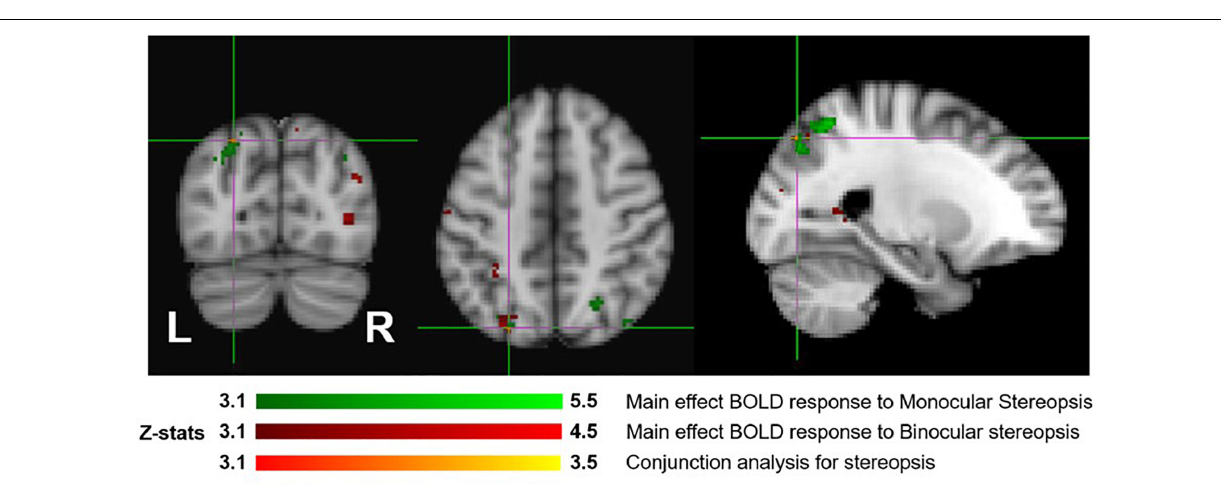
stereopsis contrast and not in the binocular stereopsis contrast. Specifically, in the monocular stereopsis contrast two clusters in the left parietal cortex [MNI coordinates: − 28, − 60, 54 and − 28, − 80, 36] and a cluster in the right parietal cortex [MNI coordinates: 36, − 74, 50] were identified ( Figure 8